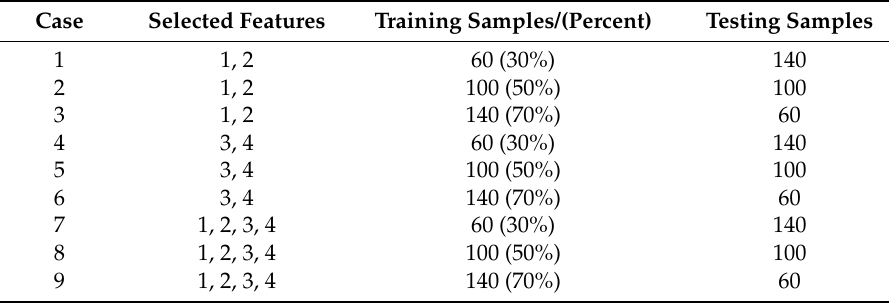
Table 6. Split strategies for training and testing